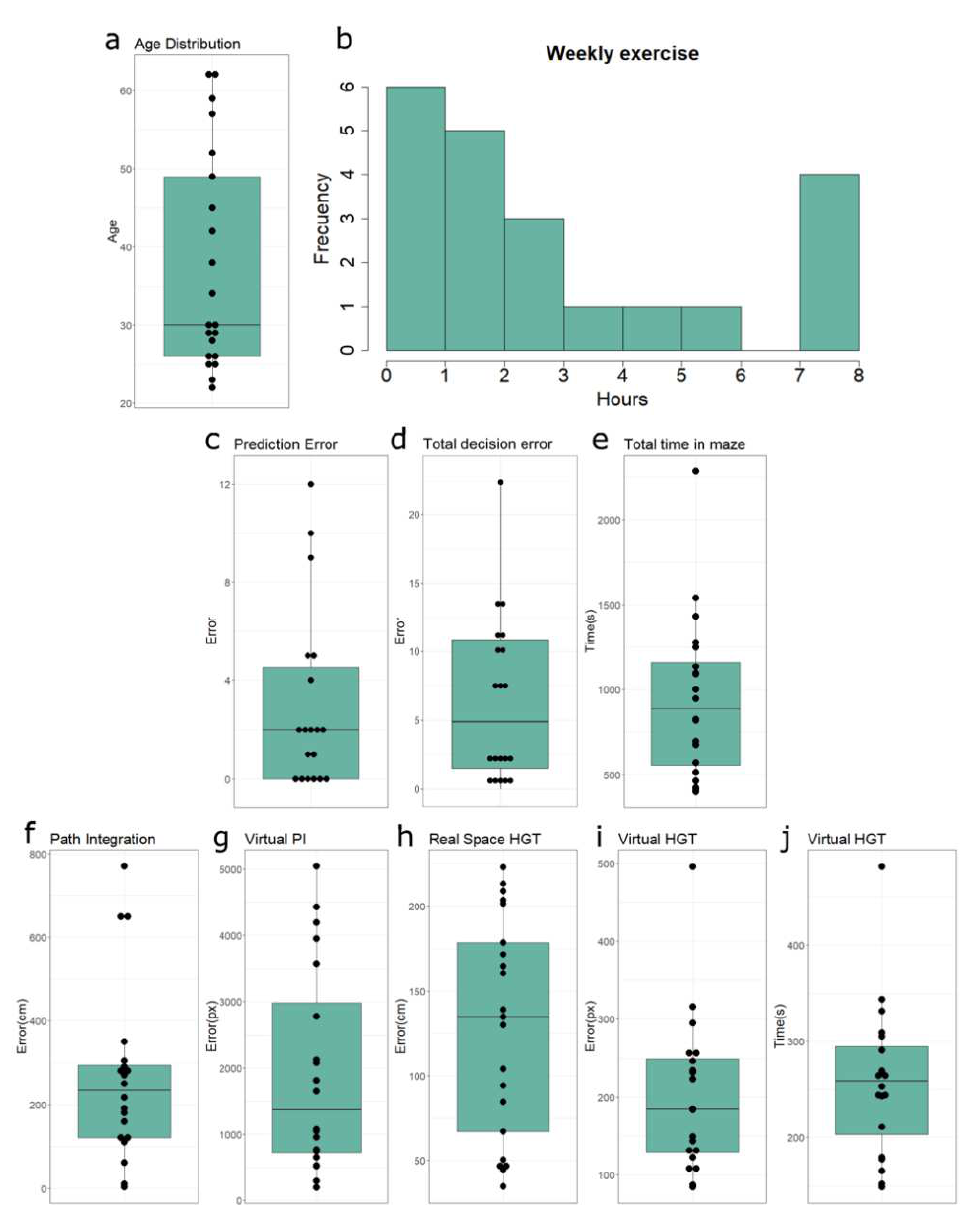
Figure 3. Group distribution and performance in the different tests. The group of participants had a wide age range ( a ) and was heterogeneous in the number of hours of exercise per week ( b ). Parameters measured for the multiple-choice maze-like test ( c – e ), path integration ( f , g ), and hidden goal test ( h – j ). A great variability can be seen for all the tests, either real-space ( c – f , h ) or virtual ( g , i , j ). Each dot represents 1 person. (PI: Path Integration, HGT: Hidden Goal